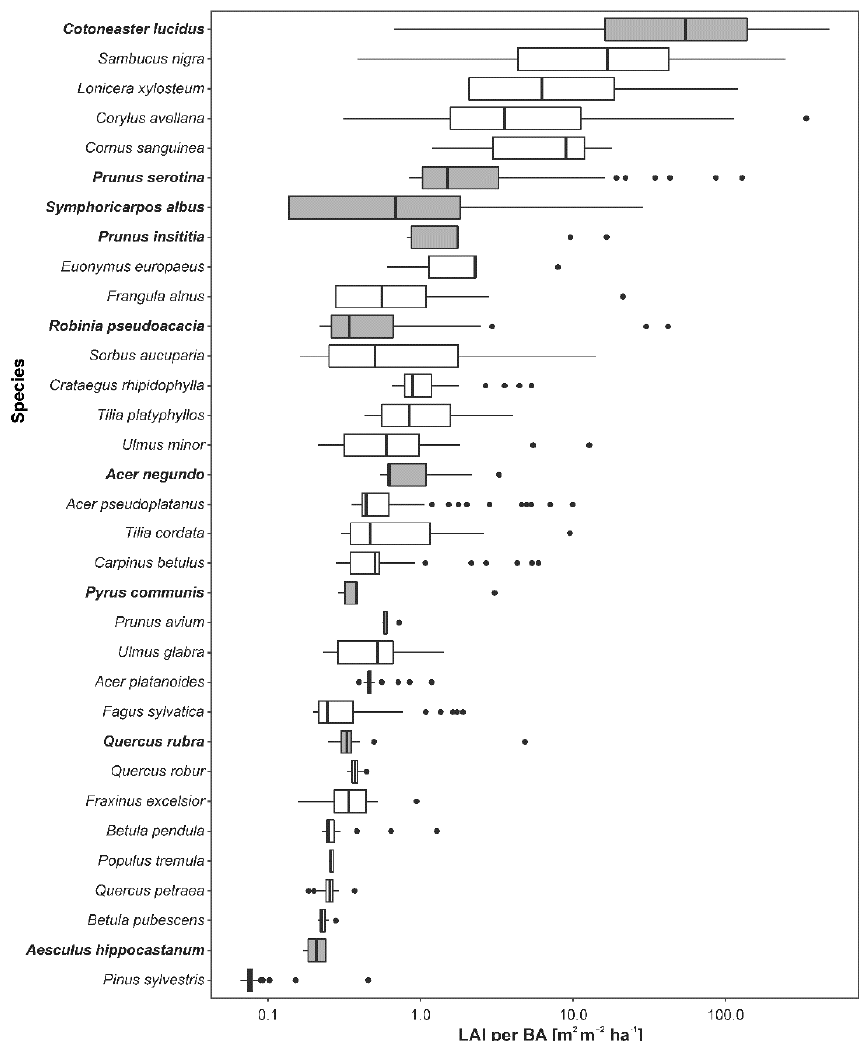
Figure 4. Distributions of LAI to BA ratio (relation of leaf area to basal area, m 2 of foliage per m 2 ha − 1 of basal area) for tree species (alien species bolded and with grey boxes), including all specimens (without DBH threshold). Only species occurring in at least five plots were presented. Boxplots indicate the first and third quartiles, the line inside the box indicates the median, and whiskers indicate the minimum and maximum without outstanding observations (>1.5 interquartile range). Note log-transformation of x axis.